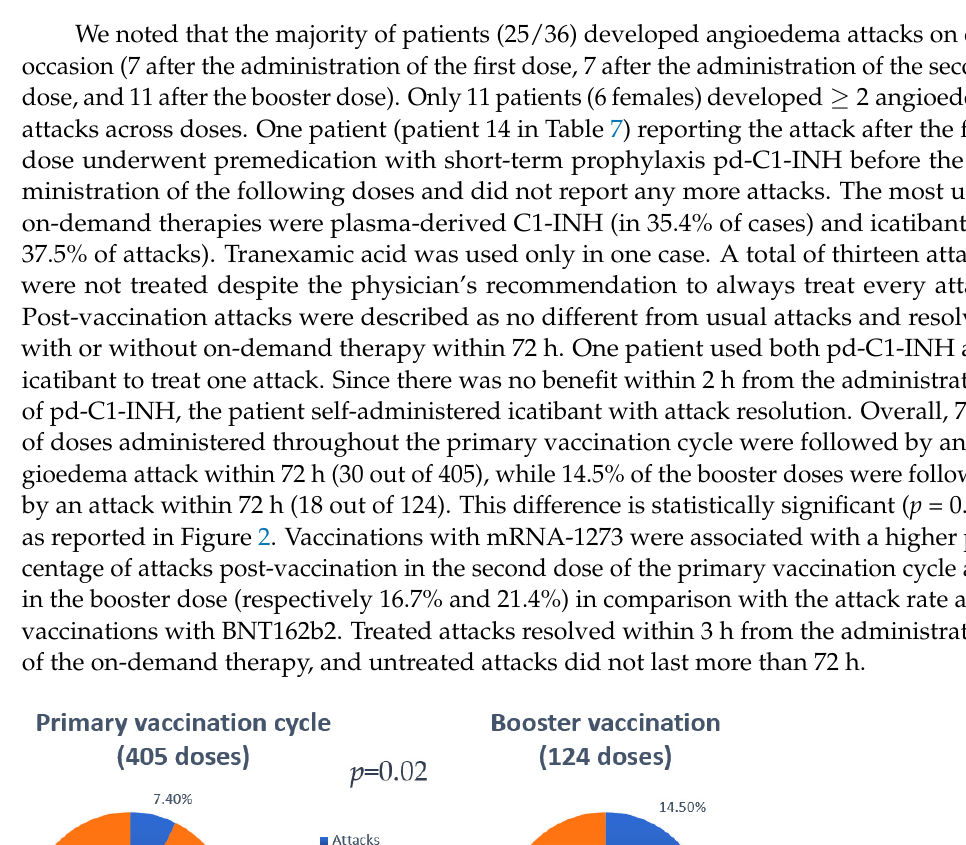
Figure 1. Localization of angioedema attacks following ( ≤ 72 h) the primary vaccination cycle and the booster dose.